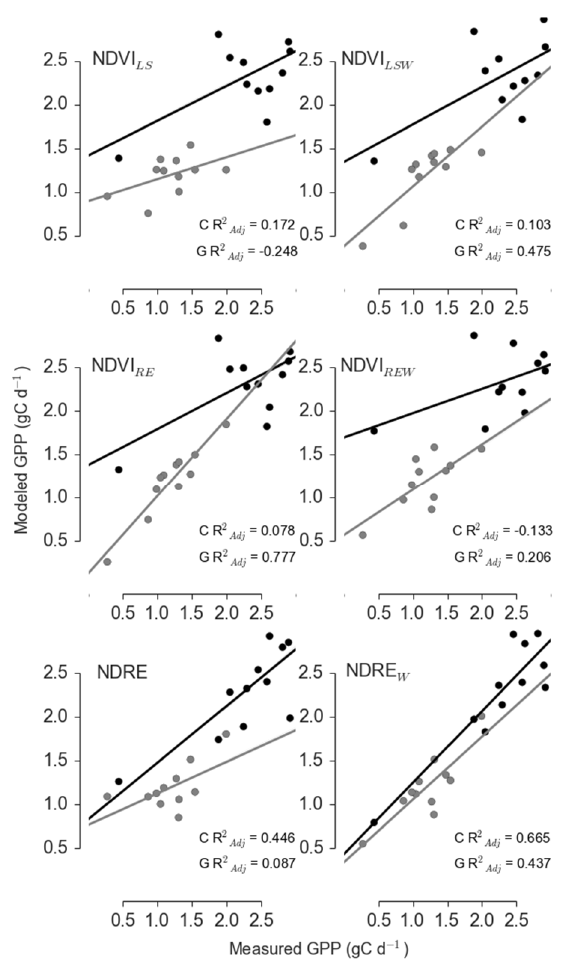
Figure 5. One to one plots of tower derived (measured) and predicted (modeled) gross primary